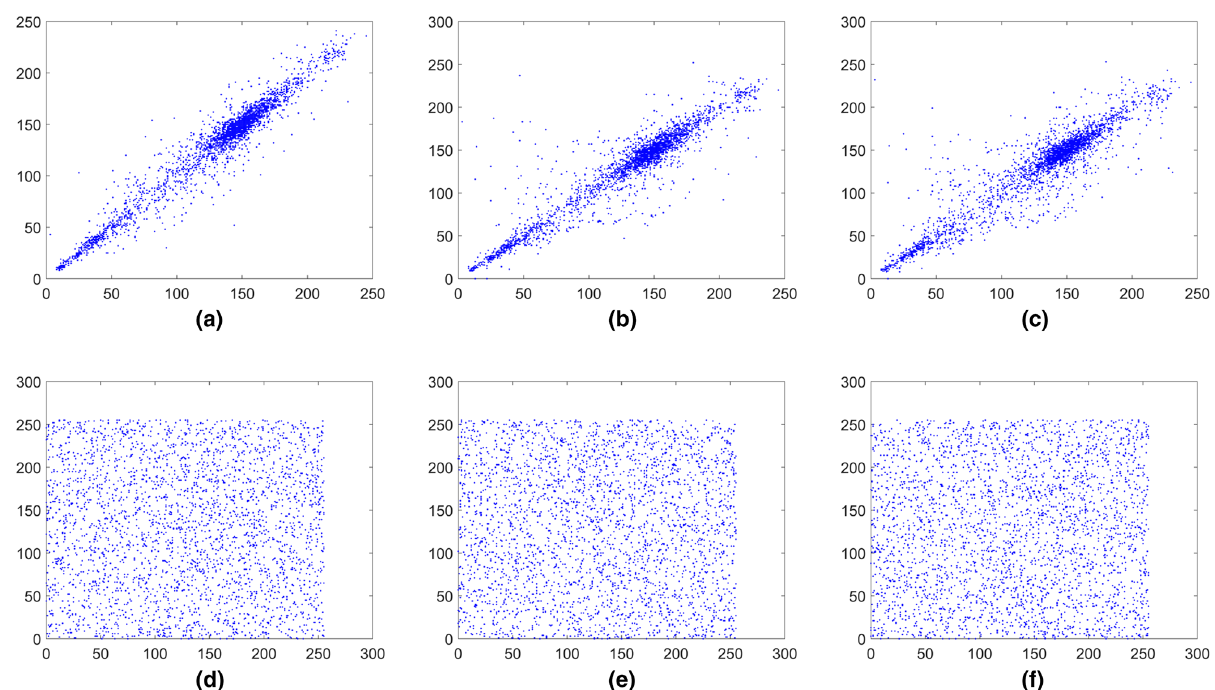
Figure 15. Distribution of adjacent pixels of the image Boat.512 and its encrypted images. ( a ) Horizontal direction of the image, ( b ) vertical direction of the image, ( c ) diagonal direction of the image, ( d ) horizontal direction of the encrypted image, ( e ) vertical direction of the encrypted image, ( f ) diagonal direction of the encrypted